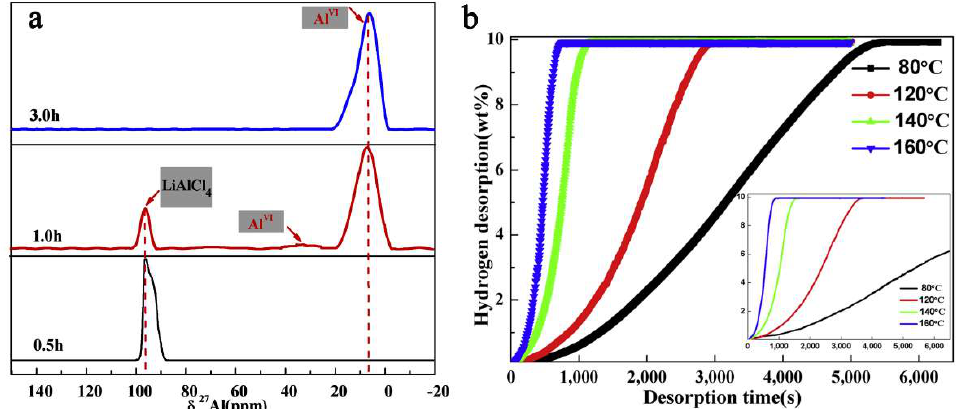
Figure 12. Solid state 27 Al NMR for reactive mixture LiH/AlCl 3 /TiF 3 (3:1:0.1) after ball milling for 0.5 h, one hour and three hours ( a ); hydrogen desorption curve for final composite α -AlH 3 /LiCl-TiF 3 at temperatures 80 ◦ C, 120 ◦ C, 140 ◦ C and 160 ◦ C (inset shown for α -AlH 3 /LiCl without TiF 3 addition) ( b ). Reprinted/adapted with permission from Ref. [203]. 2019, Elsevier B.V.